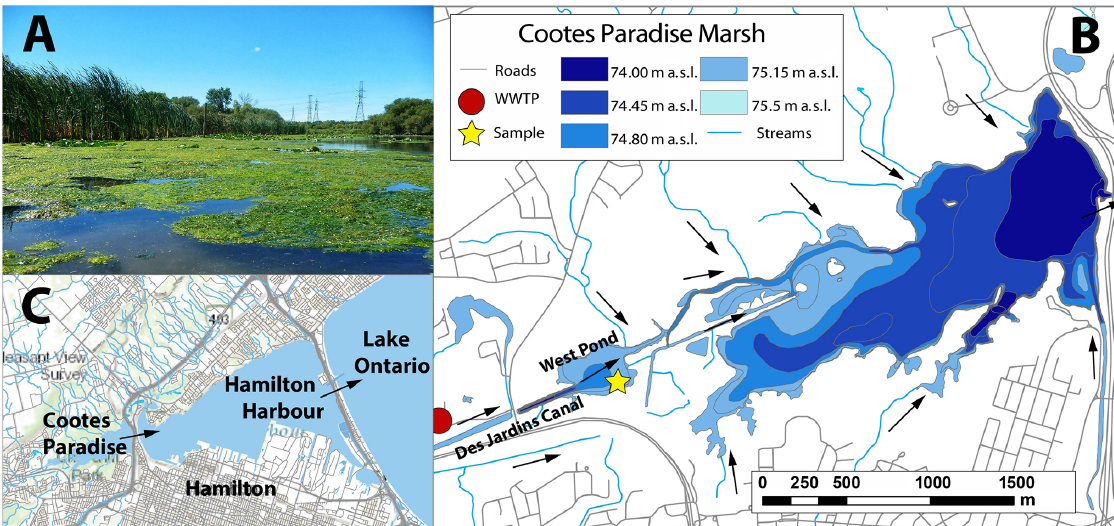
Figure 1. (a) Photograph of the sampling location taken on the day of sampling illustrating the abundance of green filamentous algae. (b) Map of Cootes Paradise and West Pond showing the sampling location, local hydrological network and the King Street Waste Water Treatment plant in Dundas, Hamilton. Colour represents area covered by surface water at different water levels (m.s.l. is metres above sea level). (c) Overview map showing the hydrological connection between Cootes Paradise, Hamilton Harbour and Lake